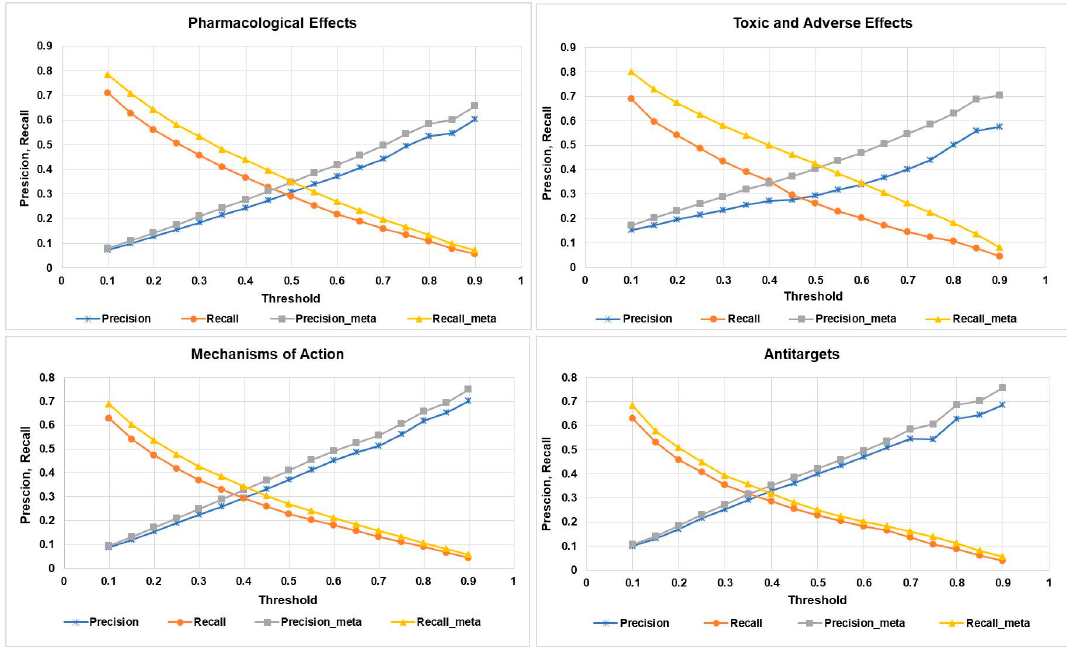
Figure 3. Average precision and recall estimates for di ff erent categories of biological activities (X axis represents the threshold values).